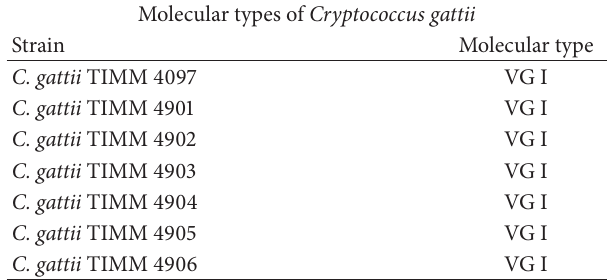
Table 1: The molecular type of seven strains of Cryptococcus gattii was investigated using multilocus sequence typing (MLST) analysis. Although the mortality rate of mice infected with C. gattii TIMM 4907 was significantly higher than that of mice infected with C. gattii TIMM4901to4906,MLSTanalysisrevealedthatthemoleculartype of all seven strains was VG